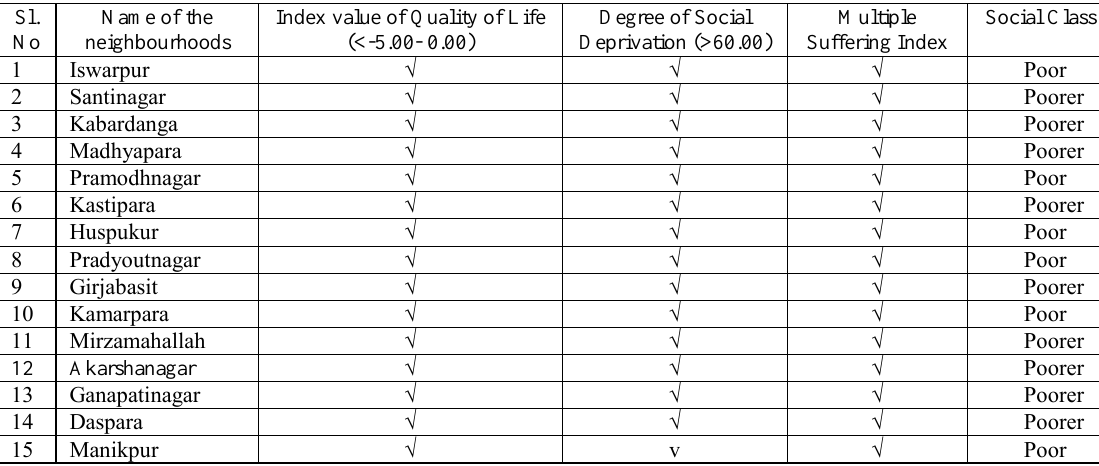
Table 1. Neighbourhoods with Poor and Poorer categories in Social